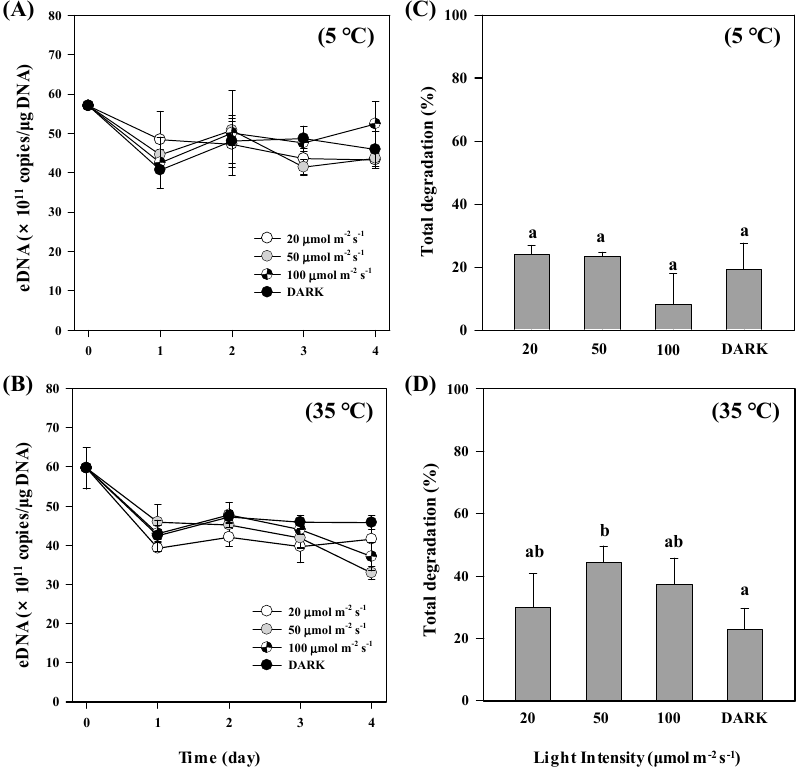
Figure 3. ExDNA concentration in samples exposed to different light intensity levels and temperatures. ( A , B ) Changes in exDNA concentration detected under different light treatments at different temperatures (5 °C and 35 °C). ( C , D ) Total exDNA degradation (%) at the end of the experiments (4 days). Different letters indicate statistically significant differences defined by p < 0.05 between treatments. Error bars represent the standard deviations among replicates within treatments.